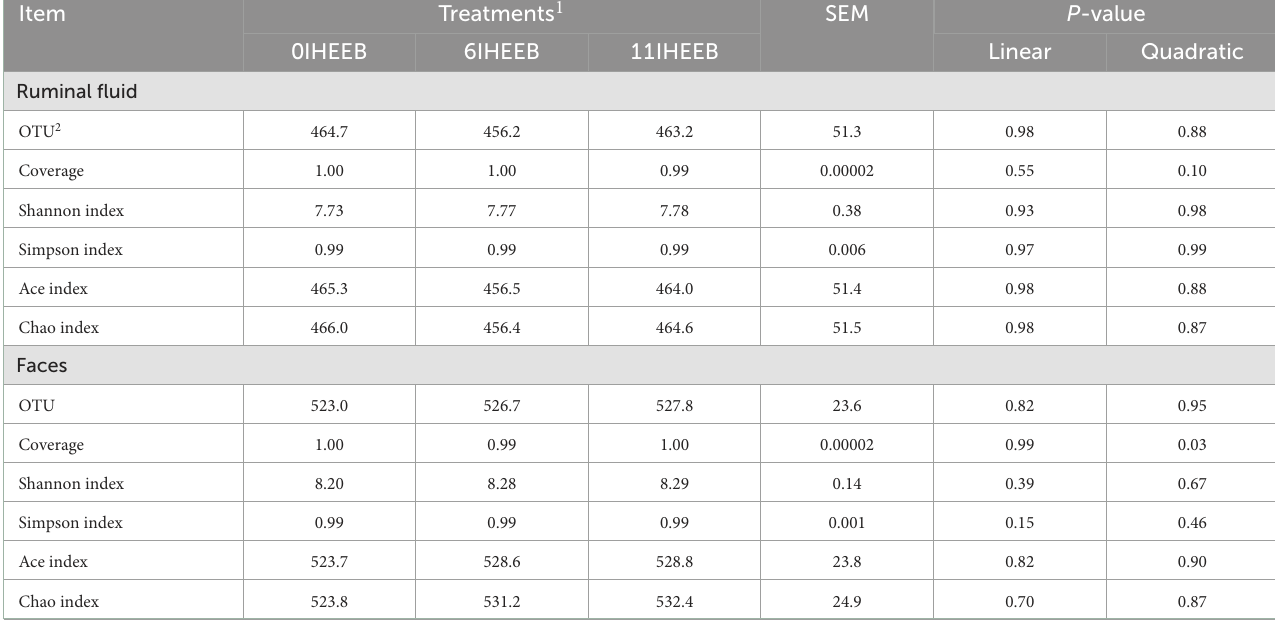
TABLE 7 Microbial diversity indices for the bacterial communities in the ruminal fluids and feces of Holstein cows fed the 3 diets. Item Treatments 1 SEM P -value 0IHEEB 6IHEEB 11IHEEB Linear